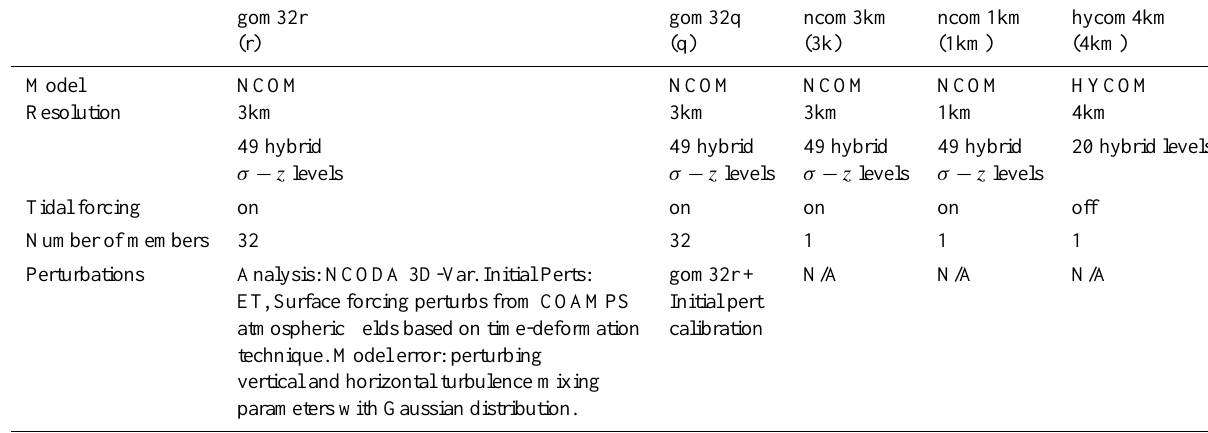
Table 1. Experimental setup and model description.